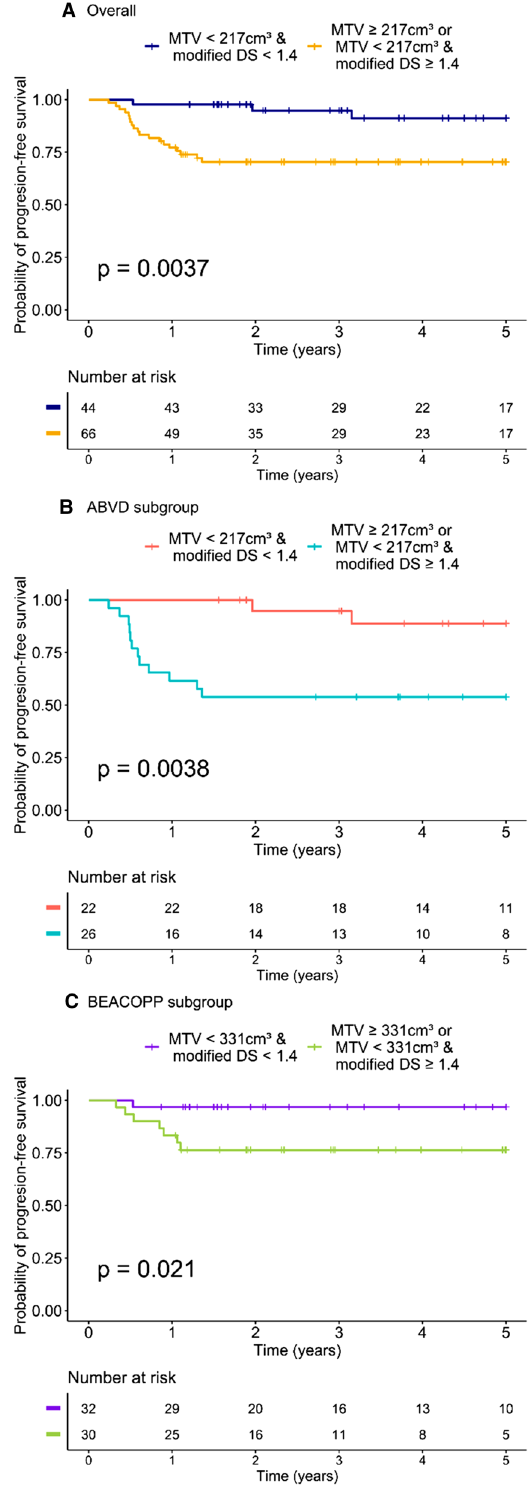
Figure 5. Five-year progression-free survival analysis using two risk categories of patients according to total metabolic tumour volume (TMTV) and modified Deauville